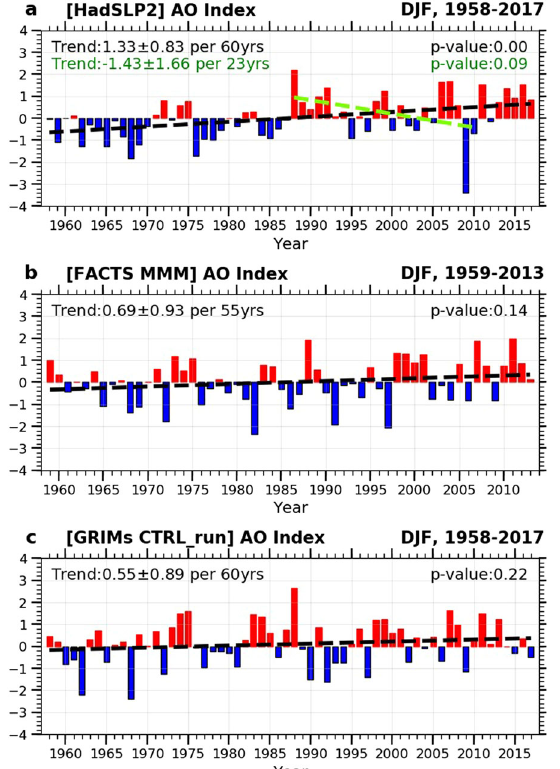
Fig. 1 Long-term trends of AO in observation and AMIP-type simulations. The AO index in ( a ) HadSLP2 data (1958 – 2017), ( b ) NOAA FACTS multi-model mean (Method, 1959 – 2013) and ( c ) GRIMs CTRL_run (Method, 1958 – 2017). The black dashed line indicates a linear trend of each AO index. The black numbers in the upper-left and upper-right sides of each panel denote the linear trend of AO index with a 95% con fi dence interval and its p-value, respectively. The green line and numbers in a denote the linear trend and the corresponding values during 1988 –